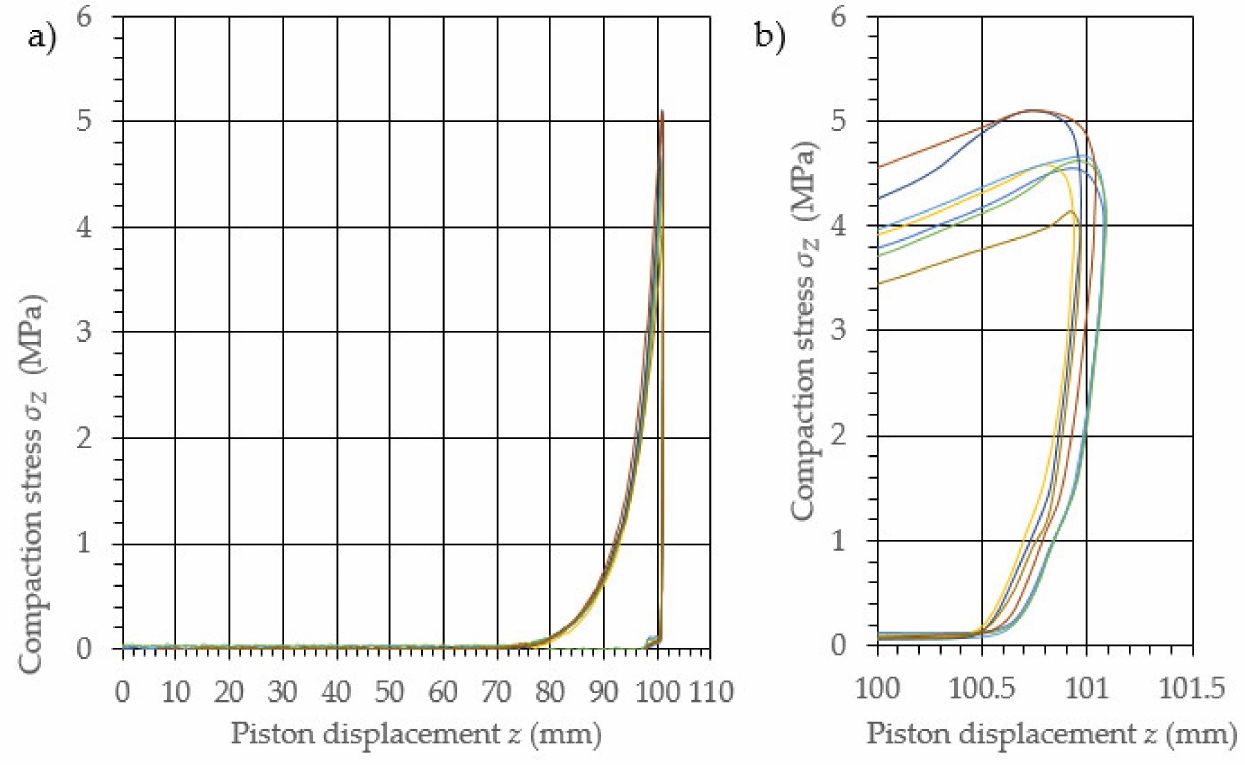
Figure 5. Characteristic curves for the compression with relaxation of dry ice with a final density of 1225.2 kg/m 3 . ( a ): The overall course of the characteristics; ( b ): an enlarged relaxation section of the compacted